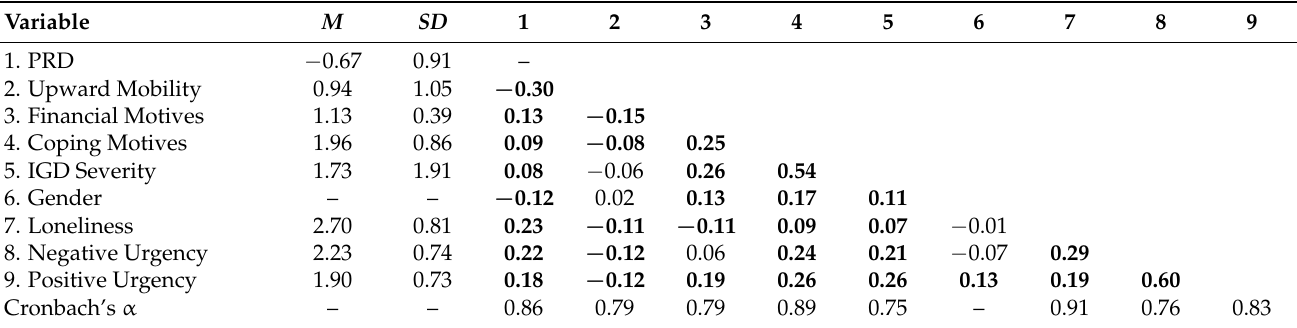
Table 2. Study 1’s descriptive statistics, internal consistencies, and correlations for main variables.